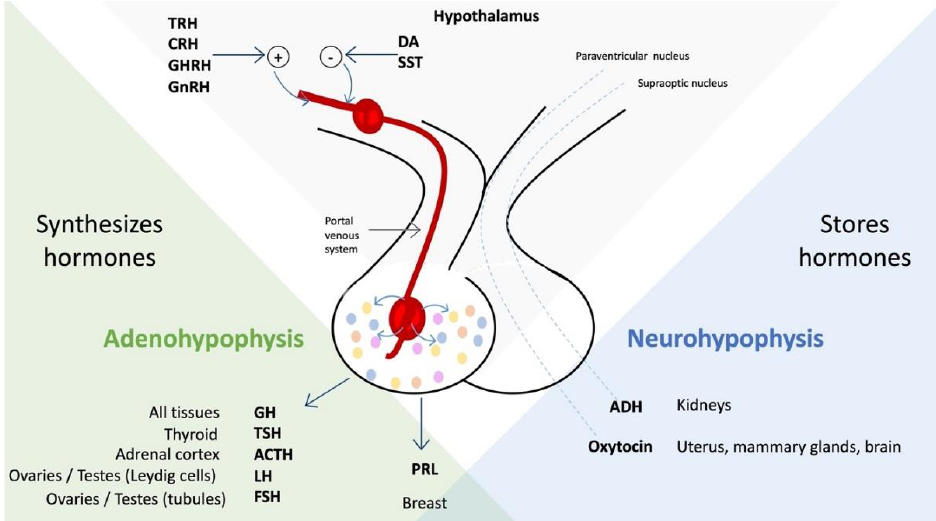
Figure 1. Relationships among hypothalamic hormones, pituitary hormones, and target organs.